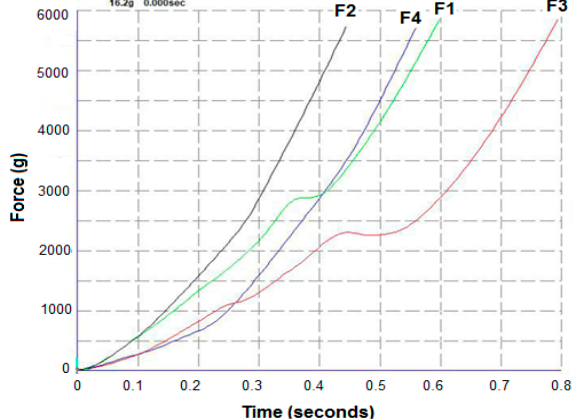
Figure 5. Force and travel time (as function of strain) profiles of the bioink formulations: F1 (F127:drug 4:1), F2 (PLA/PEG:drug 49:1), F3 (F127:drug 1:0), and F4 (PLA/PEG: drug 49:0) prior to the 3D printing applications (n = 3) of porous scaffolds.